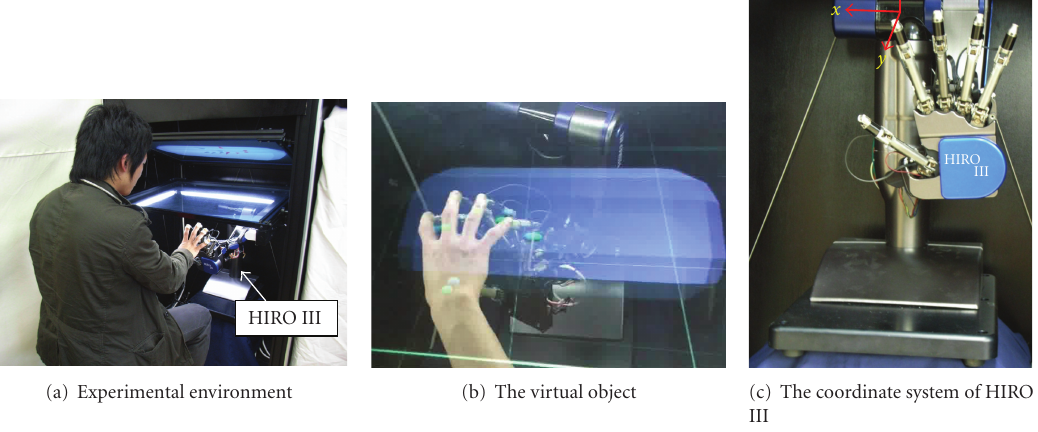
Figure 15: Experimental environment of skill transfer.